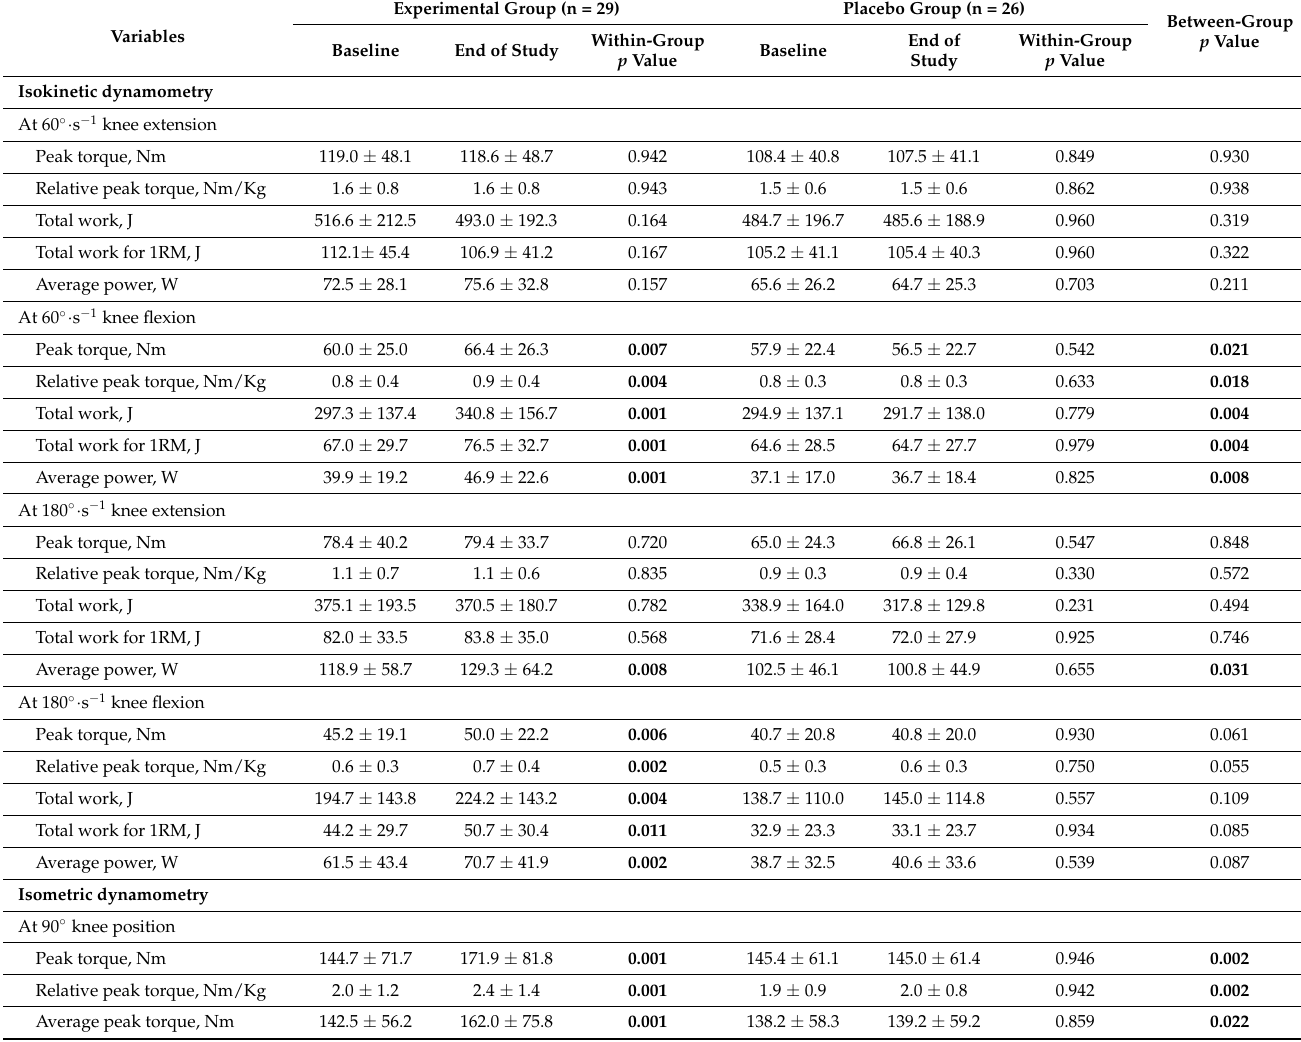
Table 5. Changes in muscle function of knee isokinetic and isometric dynamometry after 8 weeks of food supplementation with a cucumber extract or